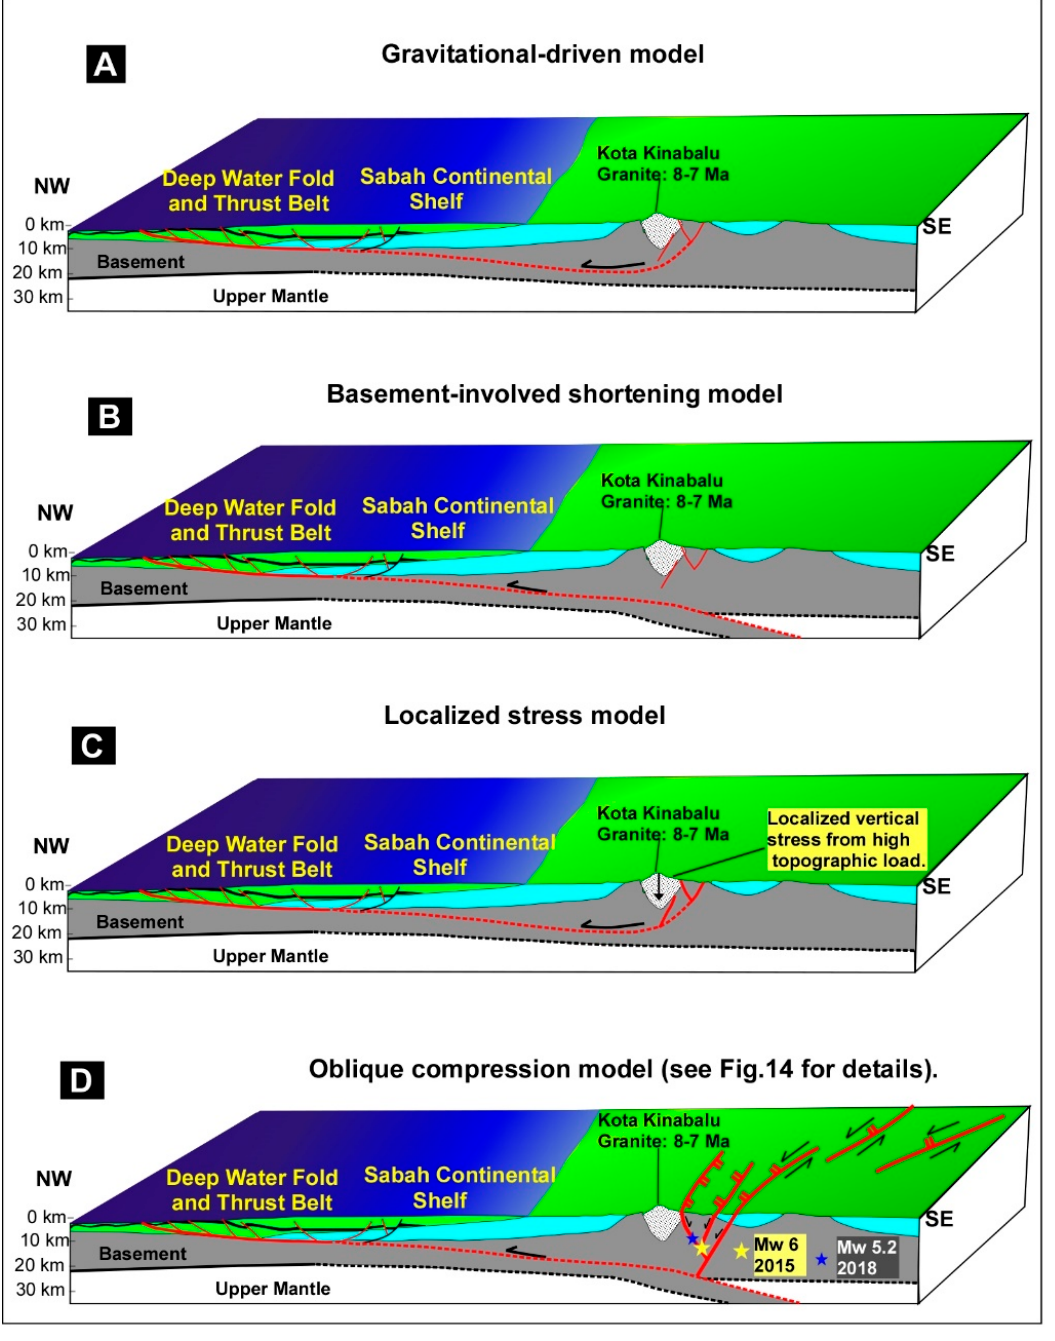
Figure 13. ( A ) Gravitational model in which faulting in NW Borneo is associated with vertical forces (gravity). ( B ) Another model involving basement shortening where thrusts verge towards ~NW and are linked to horizontal forces related to plate tectonics. ( C ) Localized stress model in which faulting is associated with vertical forces due to granite (modified after [15]). ( D ) Oblique compression model from our study. The figure is modified after [15].